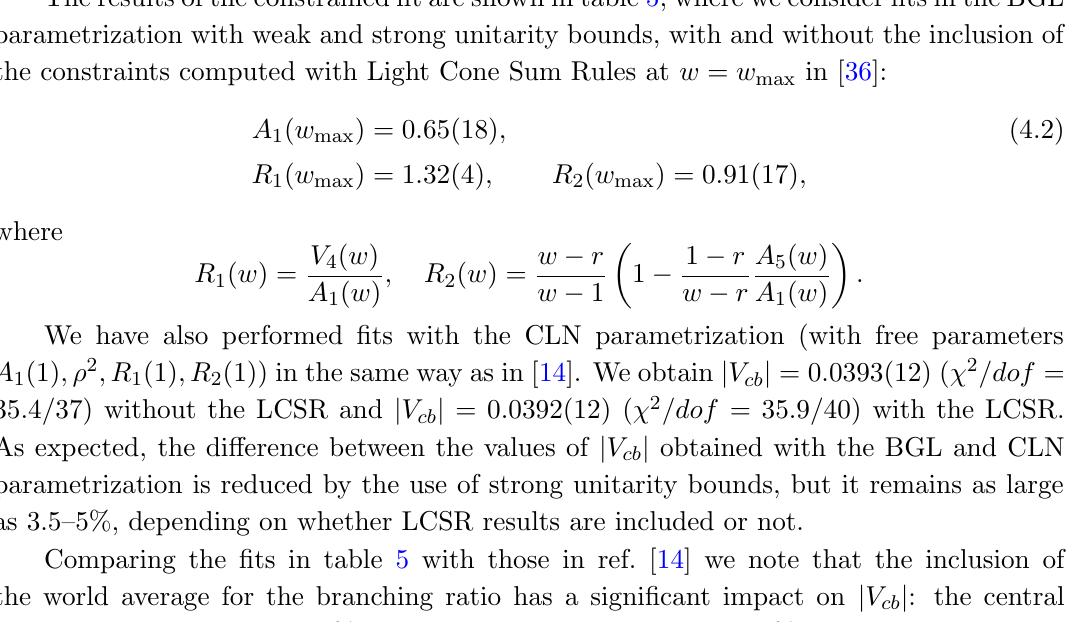
is related to the value of a A 1 0